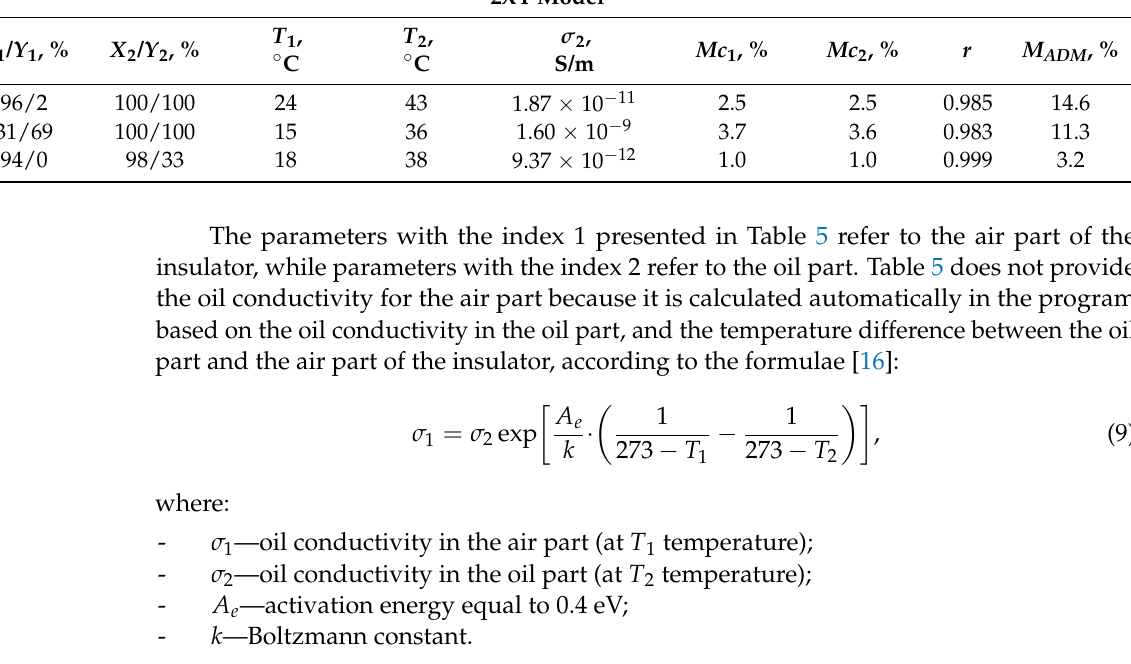
Table 5. 2 XY model parameters used in modelling the dielectric response of the tested bushings. № X 1 / Y 1 , % X 2 / Y 2 , % Bushing 1 96/2 100/100 Bushing 2 Bushing